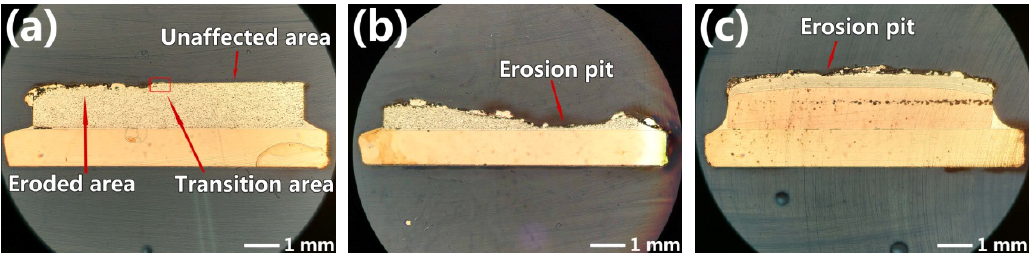
Fig. 9 Cross-sectional OM images of the three contacts after electric arc discharging test: (a) Ag/10TSC, (b) Ag/20TSC, (c) Ag/CdO.